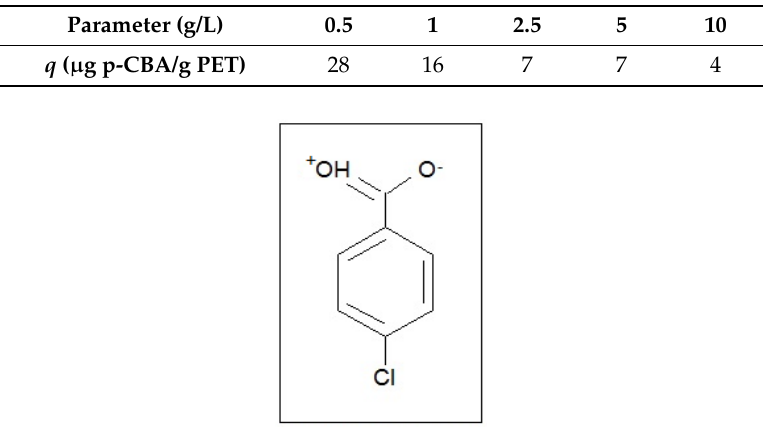
Table 4. Adsorption loading of p-CBA ( C o = 4 µ M) on different initial concentrations of PET catalyst.